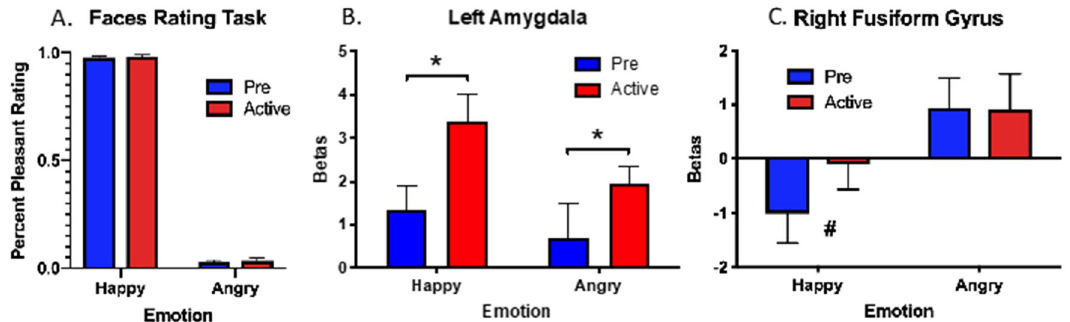
Figure 3. ( A ) Mean of percent pleasantness rating for happy and angry faces. Pleasantness ratings were higher for happy than angry faces and performance did not differ for ONABOTA-Pre and ONABOTA-Active injection. ( B ) In our a priori anatomical analysis of the amygdalae, we observed pre-post BOLD increase in left amygdala for both happy and angry faces. C) Likewise, we observed a BOLD increase in right fusiform gyrus for happy faces following the ONABOTA injection. Error bars show standard error of the mean. * indicates p < 0.05, # indicates p =